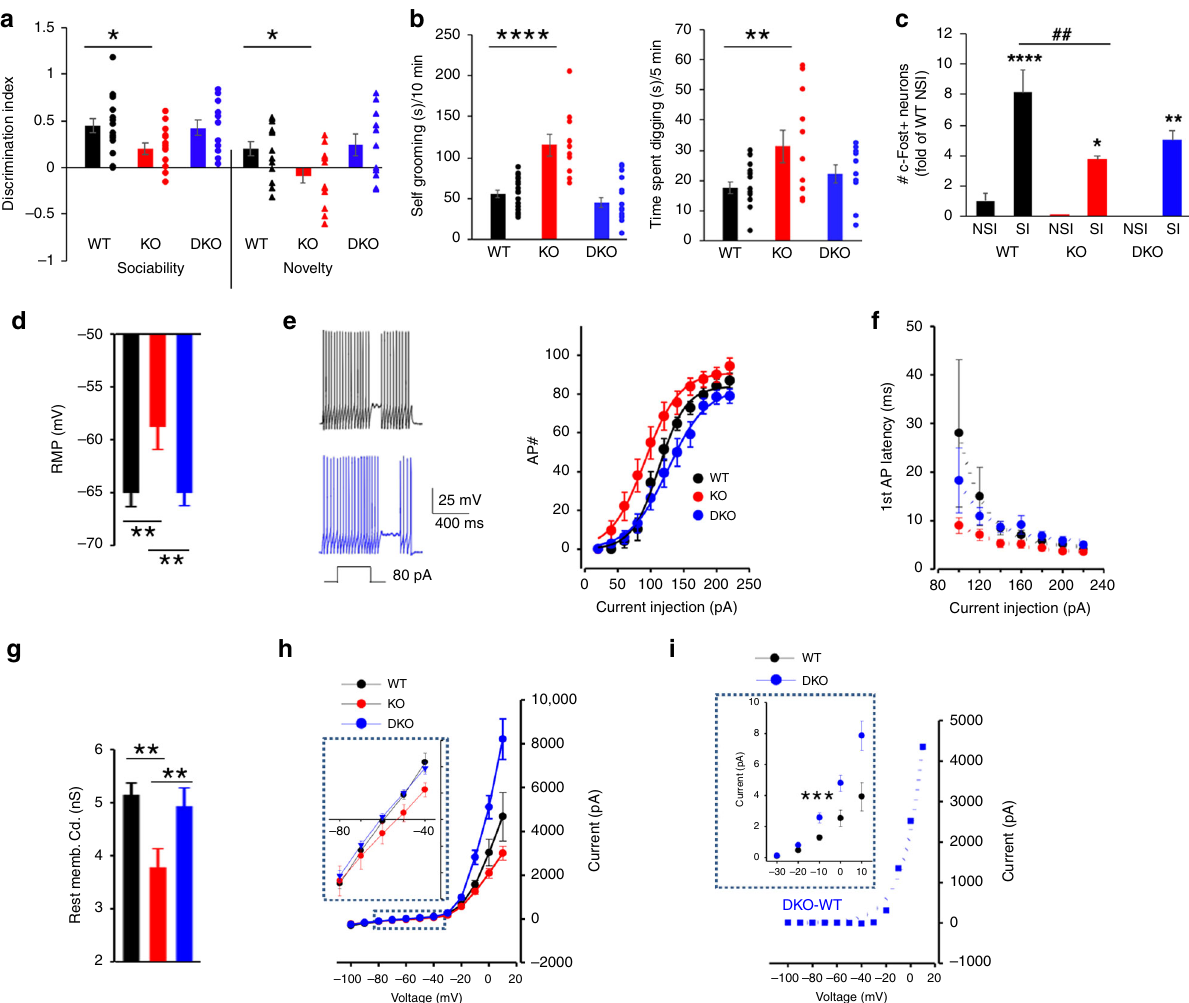
Fig. 7 Autism-like behaviors and most PV interneuron properties were normalized in PV-DKO mice. a – b Social interaction and repetitive behaviors. DKO, n = 11 ( a ), 17 (grooming) and 11 (digging). c c-Fos + L2/3 ACC neurons in naïve mice and after social interaction. *, **, **** are SI compared to NSI for each genotype. n = 4 mice per genotype per condition. In PV-DKO mice, PV neurons showed normalized ( d ) resting membrane potential ( n = 11 cells/5 WT mice, 20 cells/7 DKO mice), e cell membrane excitability plotted as the AP# for a given current injection, fi tted to a sigmoidal function, f latency for the fi rst spike at various current injections, fi tted to exponential decay, and g resting membrane conductance. h I-V curves of WT (black) and PV- Lmo4 KO (KO, red) and DKO (blue) revealed normalized leak conductance and augmented (over-compensated) delayed recti fi er conductance of PV-DKO mice. i The subtraction of I-V curves between DKO and WT is shown and exponentially fi tted. Boxed insets ( h , i ) show expanded current scales; i inset: